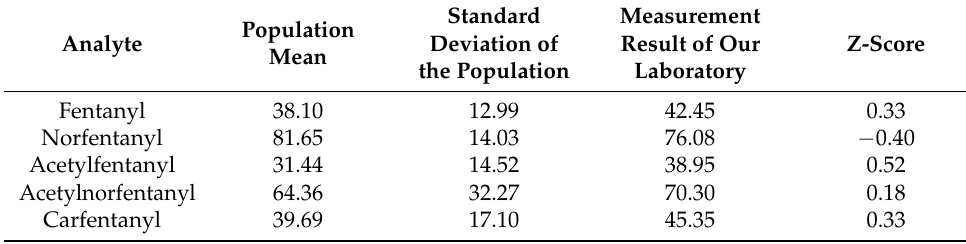
Table 3. Results obtained from proficiency